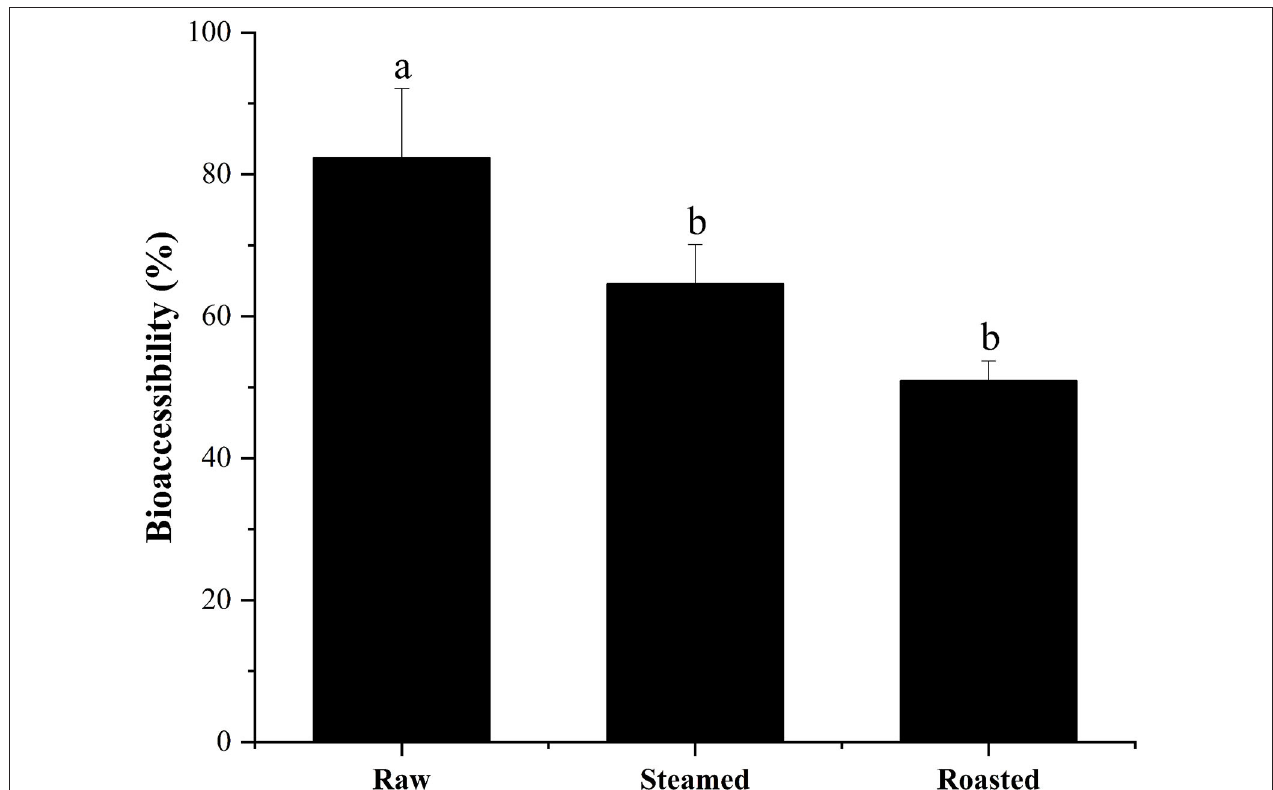
FIGURE 5 | Bioaccessibility (%, mean ± SD) of total DEL content of oyster samples using different cooking methods. Lowercase letters represent differences in bioaccessibility of deltamethrin under different cooking methods (ANOVA, p <